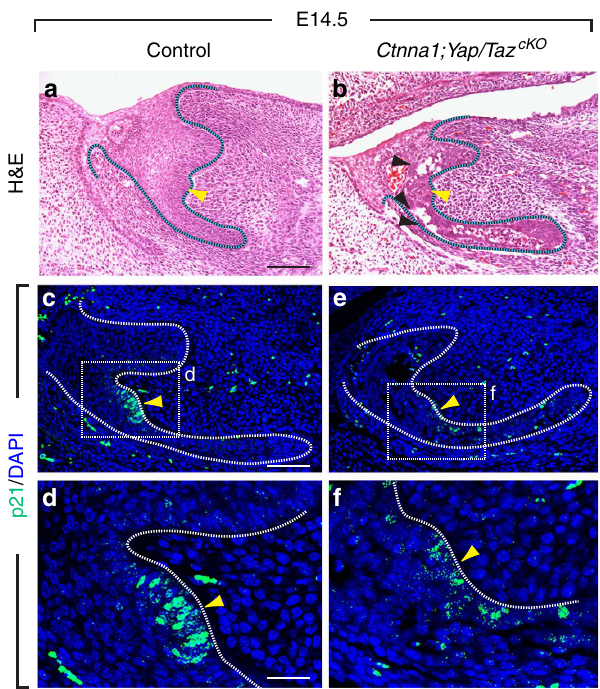
Figure 7 | The a E-catenin-YAP/TAZ signalling axis is required for further tooth germ invagination and development. ( a , b ) H&E staining of E14.5 tooth germ shows that the Ctnna1 cKO tooth germs passes the bud stage and progress to the cap stage after deletion of Yap / Taz . Black arrowheads mark tears within the tissue and yellow arrowheads mark EK. ( c – f ) p21-expressing cells (yellow arrowheads) are maintained at E14.5 in the Ctnna1 cKO tooth germ after deletion of Yap / Taz . Scale bar, 100 m m ( a , b , c , e ); 25 m m ( d , f